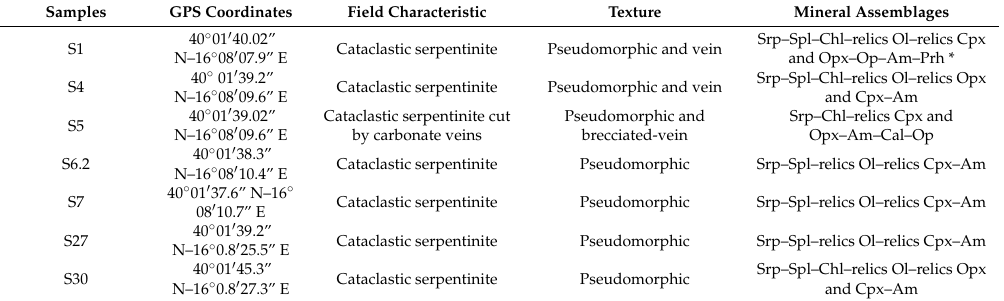
Table 1. GPS coordinates, field feature, texture, and mineral assemblages of the serpentinite samples. Symbols as [53] the exception Prh * =